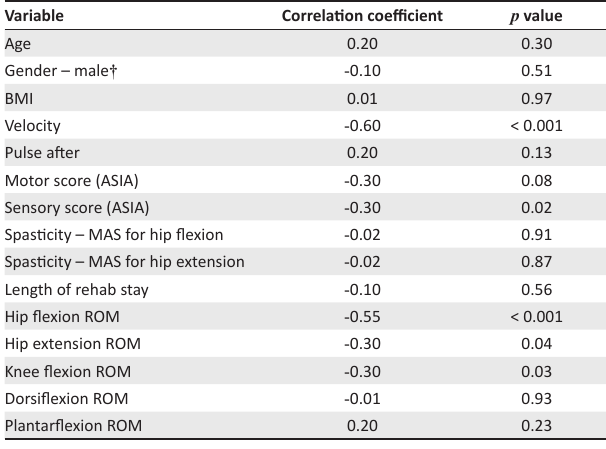
TABLE 4: The correlation of age, gender, body mass index, velocity, pulse, American Spinal Injury Association (motor and sensory scores), spasticity, length of rehabilitation stay, range of movement with energy expenditure per metre respectively.